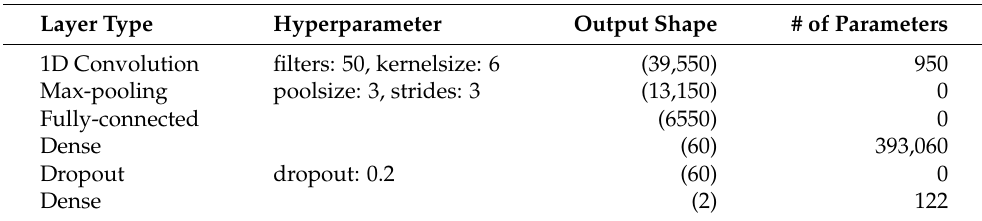
Table A1. Overview of all layers and model parameters of the proposed CNN architecture for sensor and video data synchronization. The output shape is given for one batch.